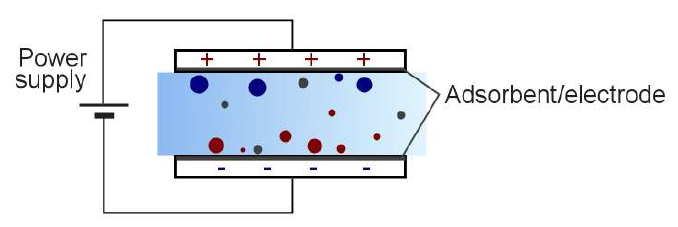
Figure 1. Schematic of the electrosorption process.